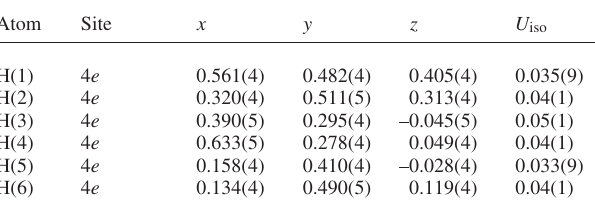
Table 2. Atomic coordinates and displacement parameters (in Å 2 )